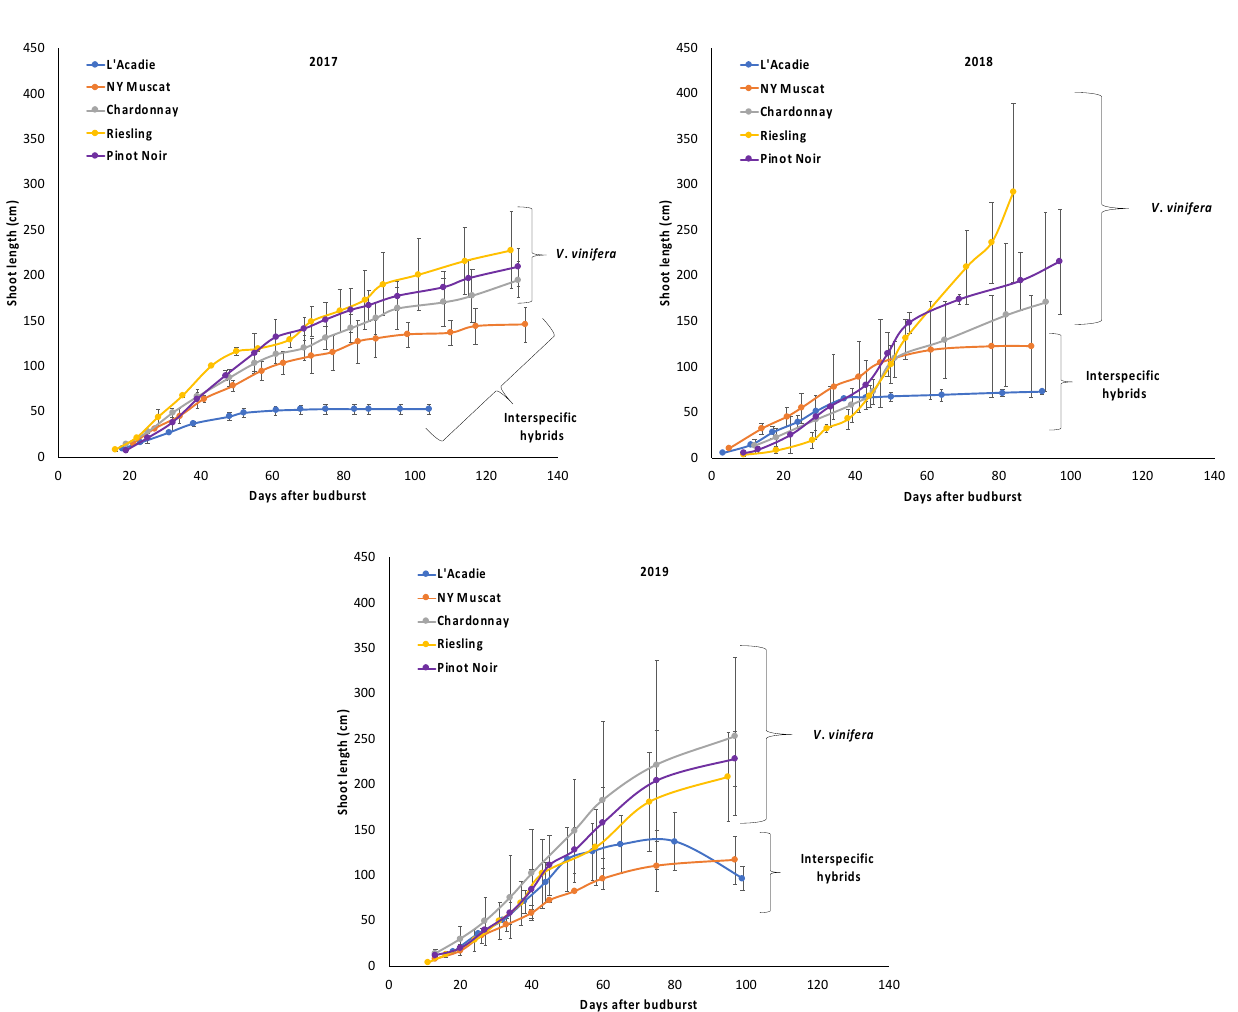
Table 5. Effect of variety on yield, yield components and water status of grapevines growing under cold climate conditions over three consecutive seasons.